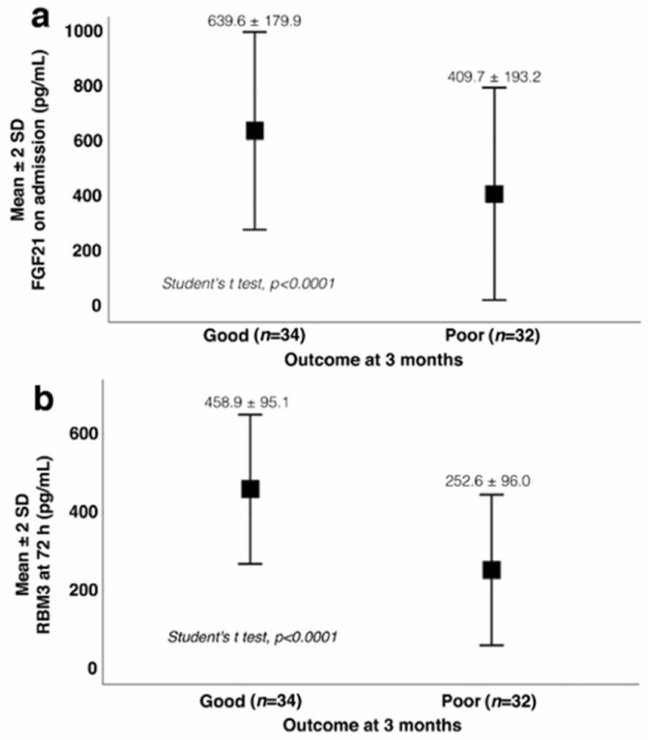
Figure 4. Analysis of serum fibroblast growth factor (FGF21) ( a ) and RNA-binding motif protein 3 (RBM3) ( b ) and their associations with the functional outcomes of